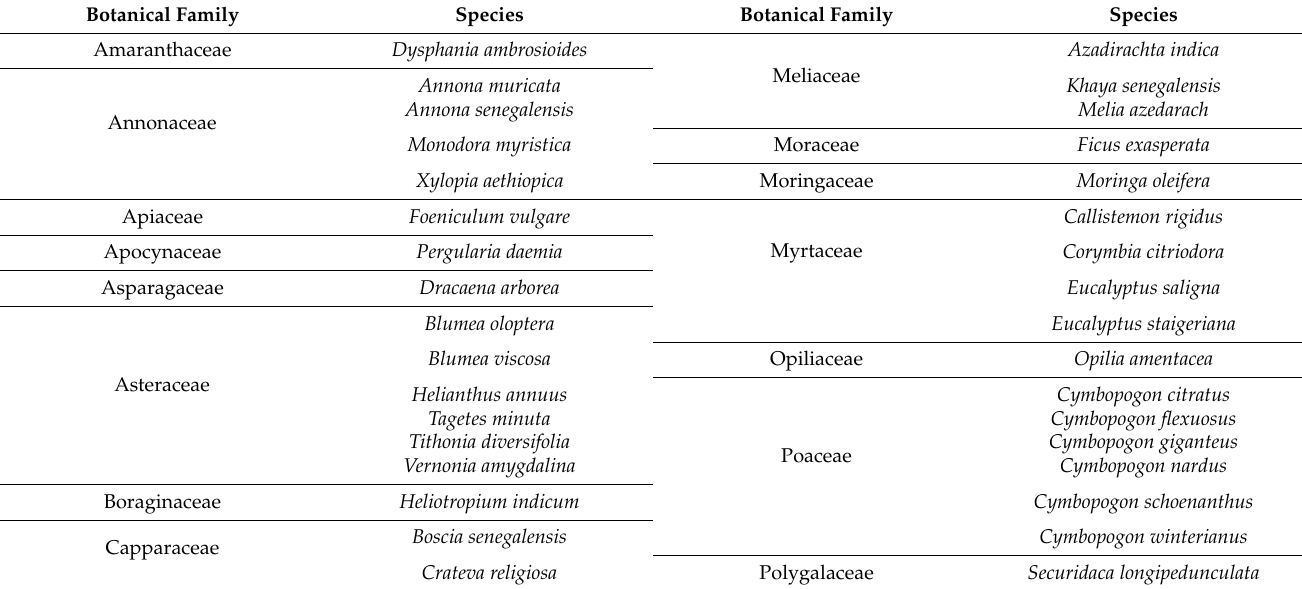
Table 3. Examples of plant species tested or applied to control Callosobruchus maculatus infestation of cowpea ( Vigna unguiculata ) stocks in